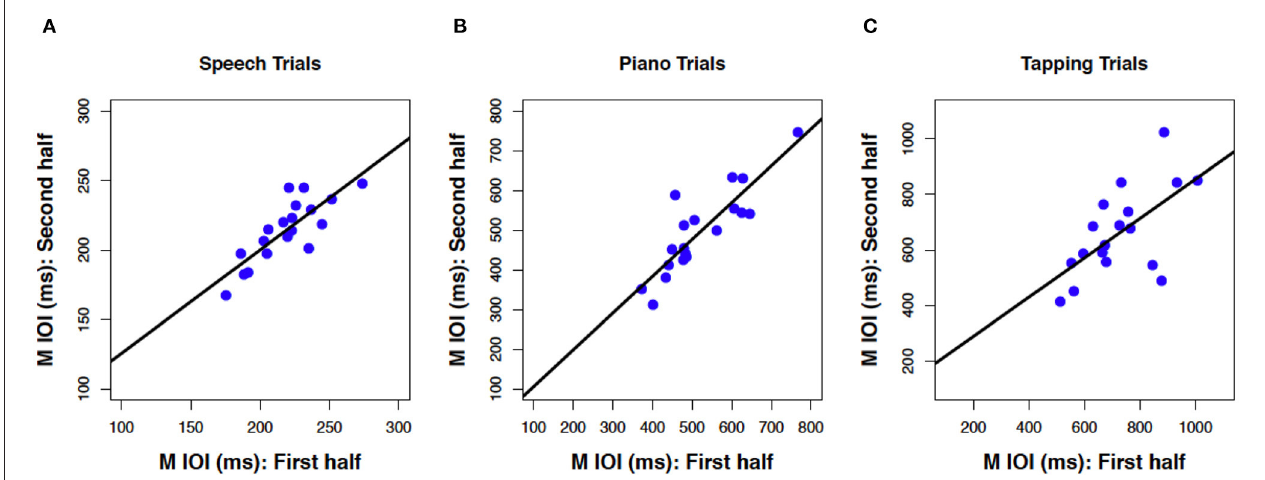
FIGURE 3 | Scatterplots relating mean IOI across for the first vs. second half of the session in speech production (A) , piano production (B) , and rhythmic tapping (C) . Regression lines and parameterization as in Figure 2 ( N = 19 A,B , N = 18 C ).